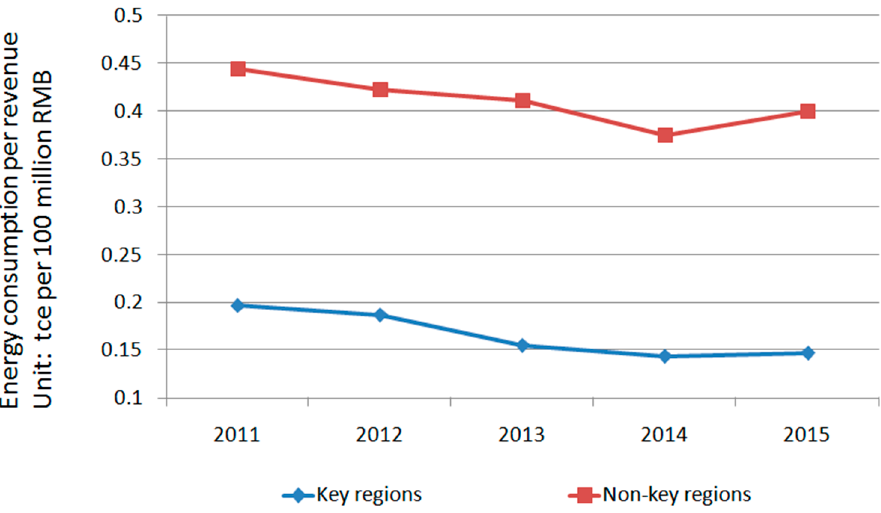
Figure 2. Energy intensity between key and non-key regions.